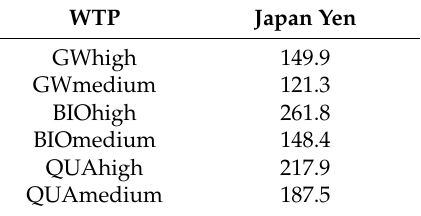
Table 5. Results of